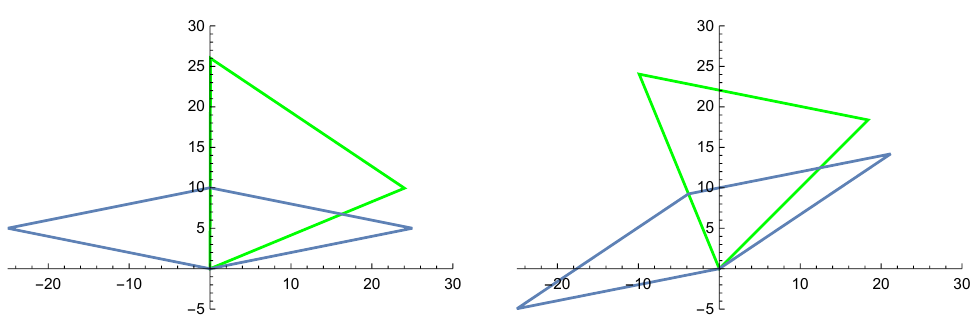
Figure 4. Double operator based on connecting two of the operators in (cid:12)gure 2a, unrotated and rotated by (cid:25)= 8.